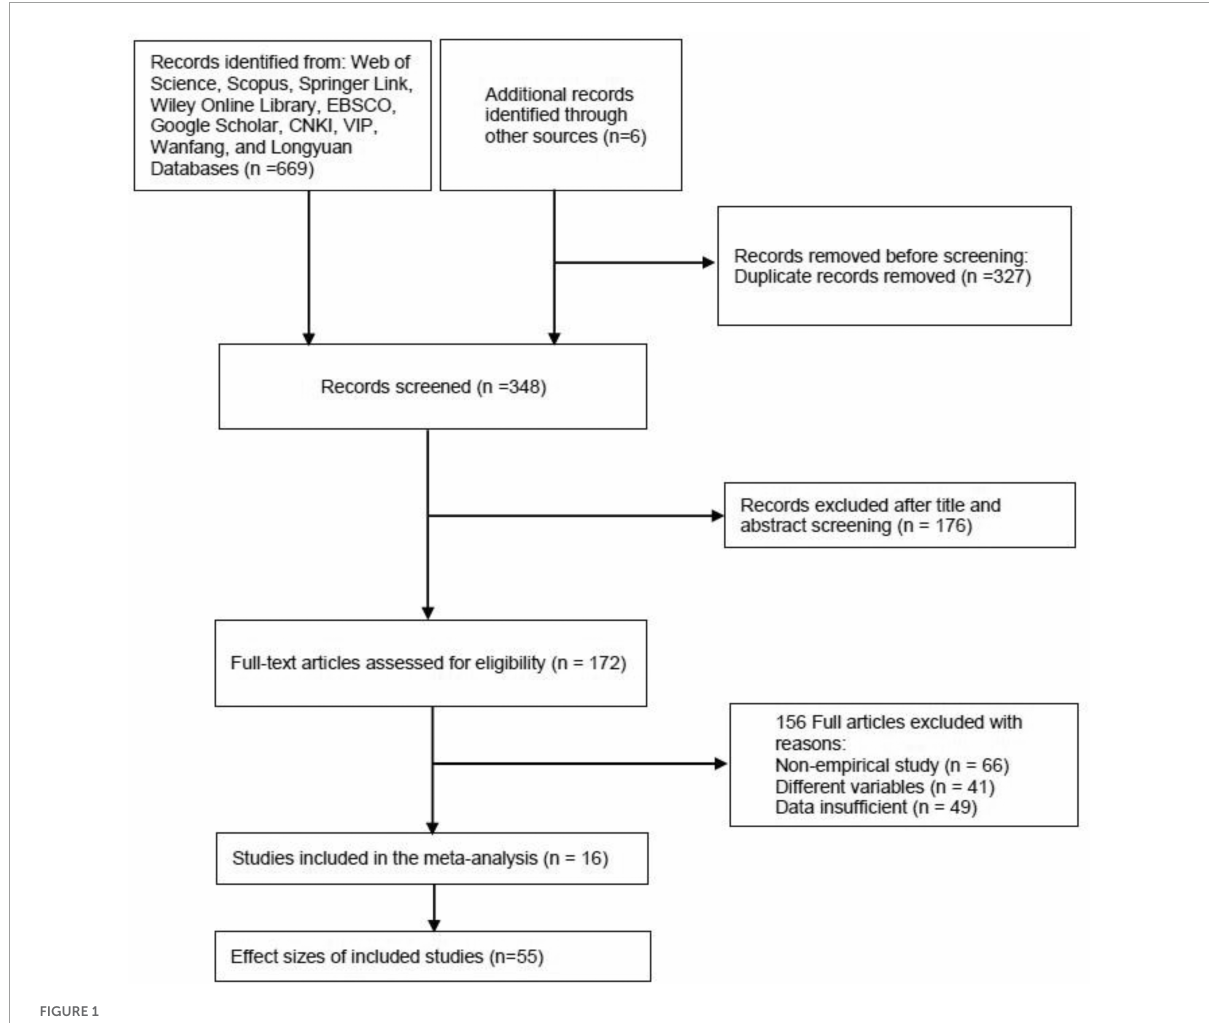
FIGURE1 Literature search and inclusion